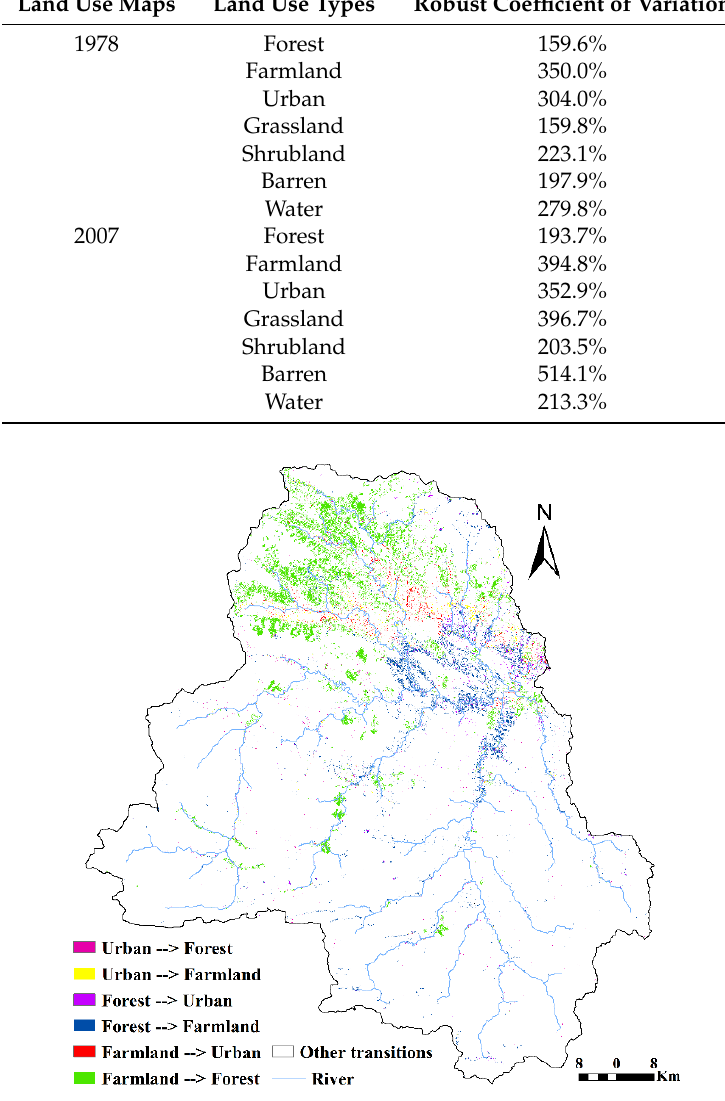
Figure 6. Land use transformation maps of the Upper Du Watershed from 1978 to 2007.